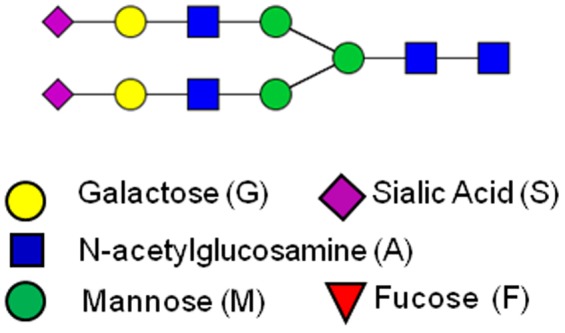
Example glycoform structure – A2G2S2 glycoform.